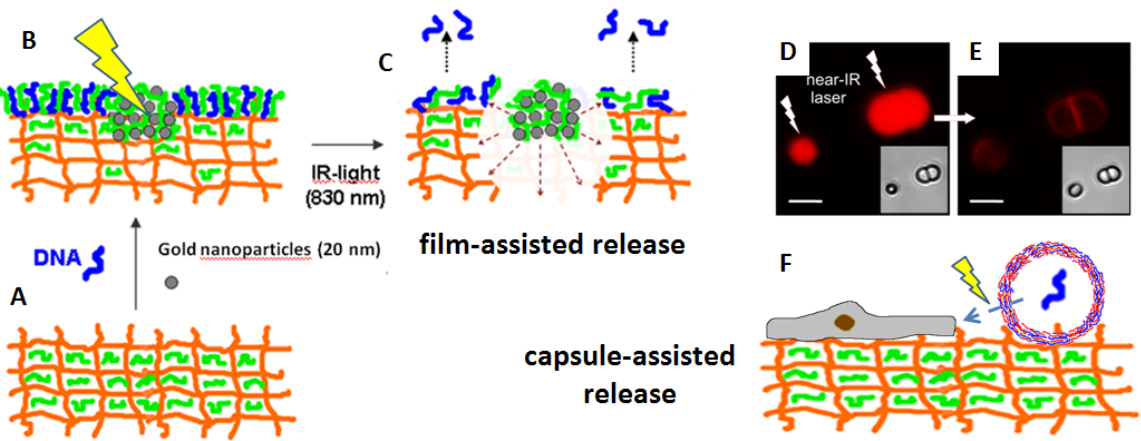
Figure 9. Schematics of the proposed mechanism of light-triggered DNA release from HA/PLL multilayers. ( A , B ) loading of the HA/PLL film (HA in orange, PLL in green) with gold nanoparticles and DNA (in blue); ( B , C ) thermal decomposition of the film around nanoparticle aggregates upon light irradiation resulting in distortion (weakening) of the interaction between DNA and the doped PLL and, as a result, in DNA release from the film. CLSM images of nanoparticle coated (poly(diallyldimethylammonium chloride)/PSS) 4 microcapsules loaded into the (PLL/HA) /PLL film before ( D ) and after ( E ) light irradiation 24 during 1s. Light power is 20 mW, wavelength is 830 nm. The scale bar is 1 μ m; and ( F ) Scheme of light-triggered biomolecule release from microcapsules to a biological cell, both located on the film. Adopted from